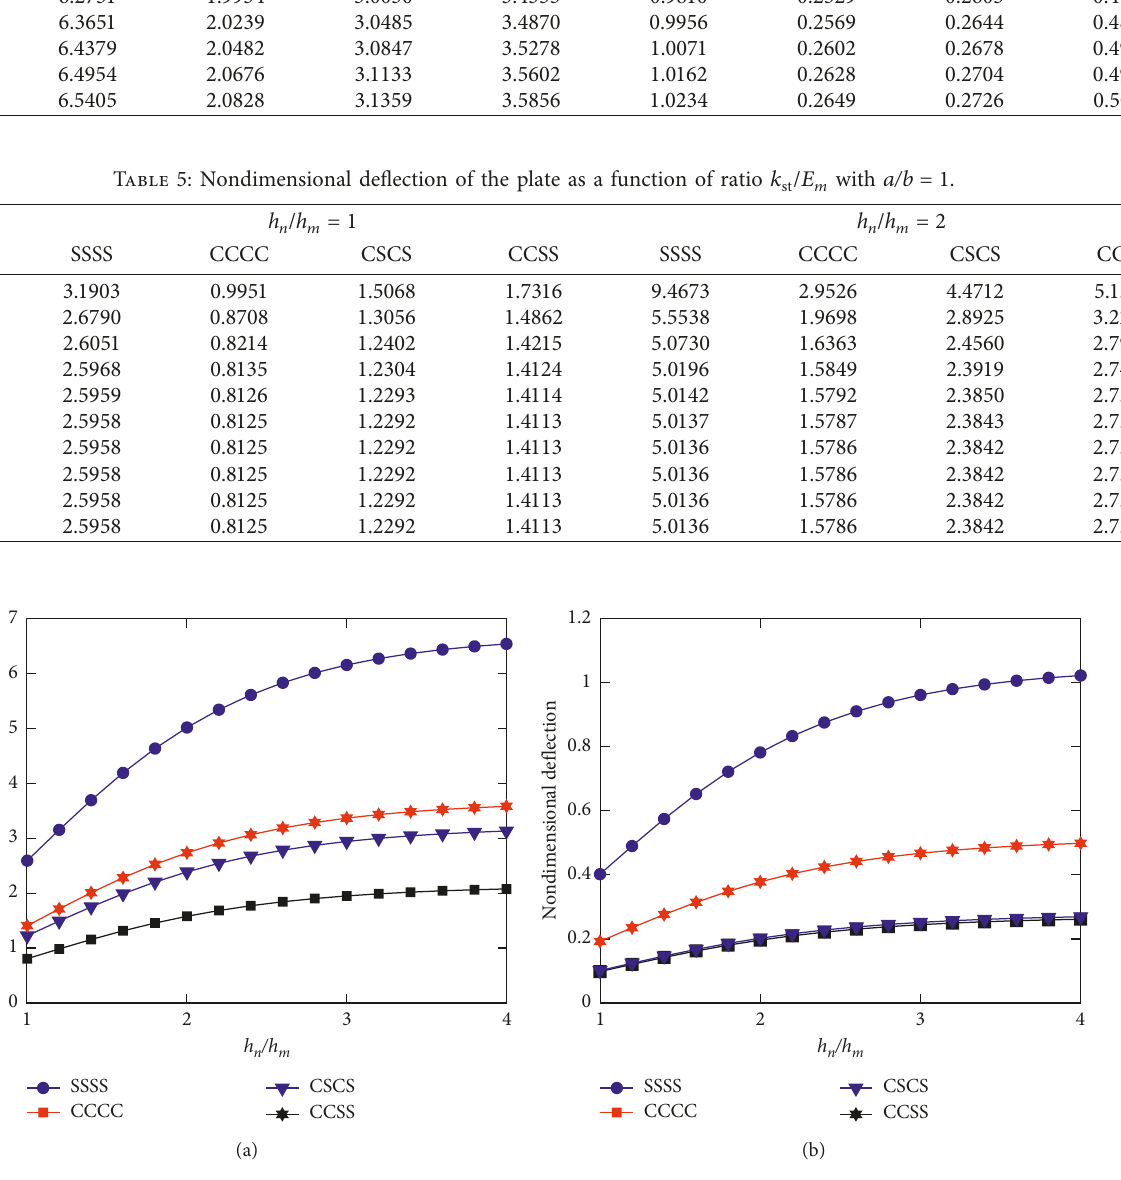
h n / m on the nondimensional transverse deflection of the plate with